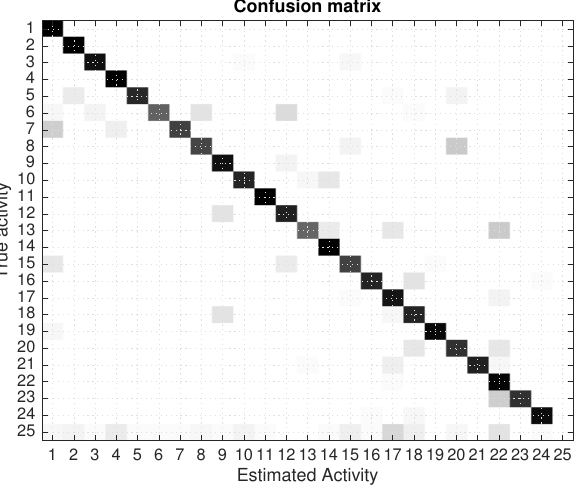
Figure 3. Confusion